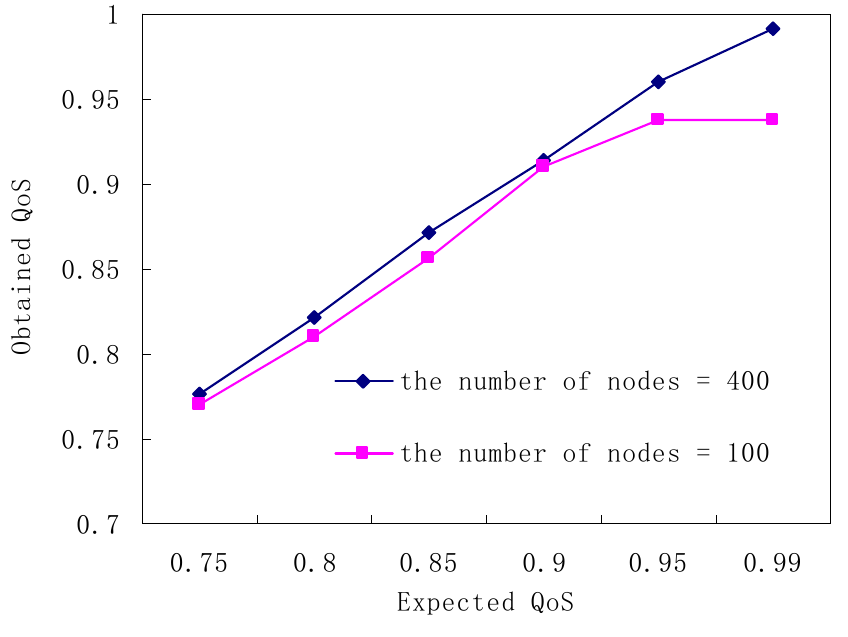
Figure 8. Expected QoS vs. obtained